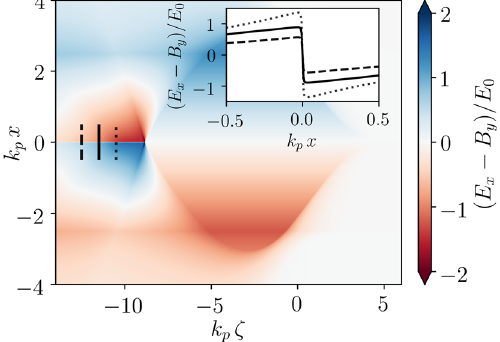
FIG. 2. Two-dimensional ( ζ , x ) map of the focusing wake- − B Þ =E field, ð E 0 . Positrons can be focused in the region x y − 14 ≲ k ζ ≲ − 9 , which widely overlaps with the positron p accelerating region. Inset: transverse dependence of focusing field at three different longitudinal locations denoted by the ζ ¼ − 12 . 5 ), solid ( k ζ ¼ − 11 . 5 ), and dotted dashed ( k p p ζ ¼ − 10 . 5 ) lines. The focusing field decays almost linearly ( k p for increasing distances from the propagation axis. The field decreases further behind the